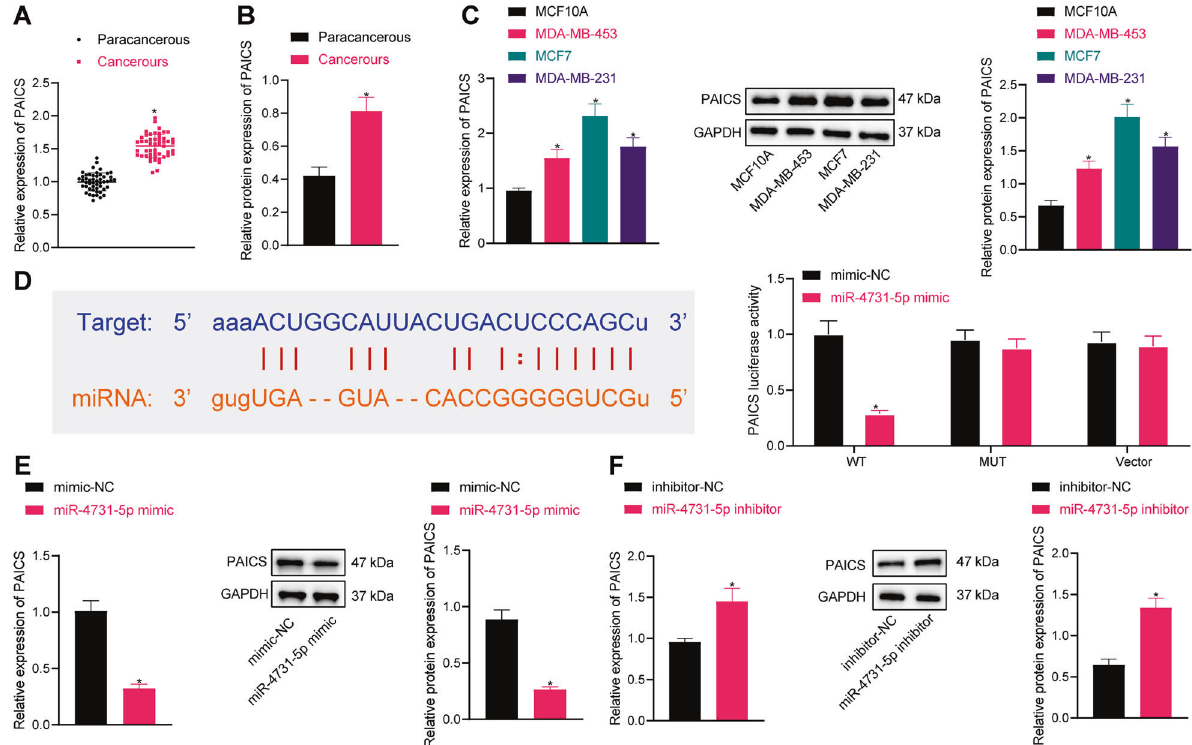
Fig. 3 PAICS is the potential target of miR-4731-5p in MCF-7 cells. A RT-qPCR was used to detect the expression of PAICS in clinical samples ( n = 50). B Western blot analysis was used to detect the expression of PAICS in clinical samples ( n = 50). C RT-qPCR, and western blot analysis were used to detect the expression of PAICS in breast cancer cells (MDA-MB-453, MCF-7, and MDA-MB-231) and breast epithelial cell. D Bioinformatic analysis was used to predict the binding site of miR-4731-5p and PAICS. E RT-qPCR was used to detect the expression of PAICS after miR-4731-5p mimic treatment. F Western blot analysis was used to detect the expression of PAICS after miR-4731-5p inhibitor treatment. Measurement data were expressed as mean ± standard deviation. Comparison between two groups was performed through an independent t test. * p < 0.05 compared with adjacent normal tissues, MCF10A cell, mimic NC, or inhibitor-NC